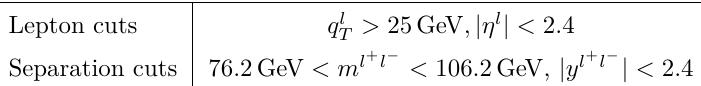
Table 2. Fiducial for Z → l + l − at